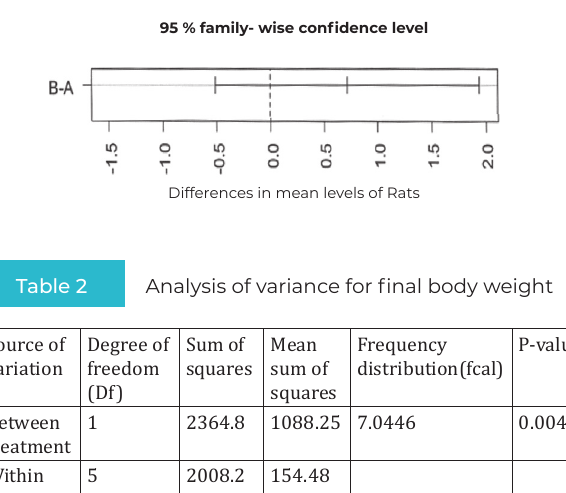
Figure 4 - 95% family–wise confidence level for testes weight, shows no significant difference in mean levels due to intersection of the horizontal line (B-A) and the broken vertical line at 0.0 point.